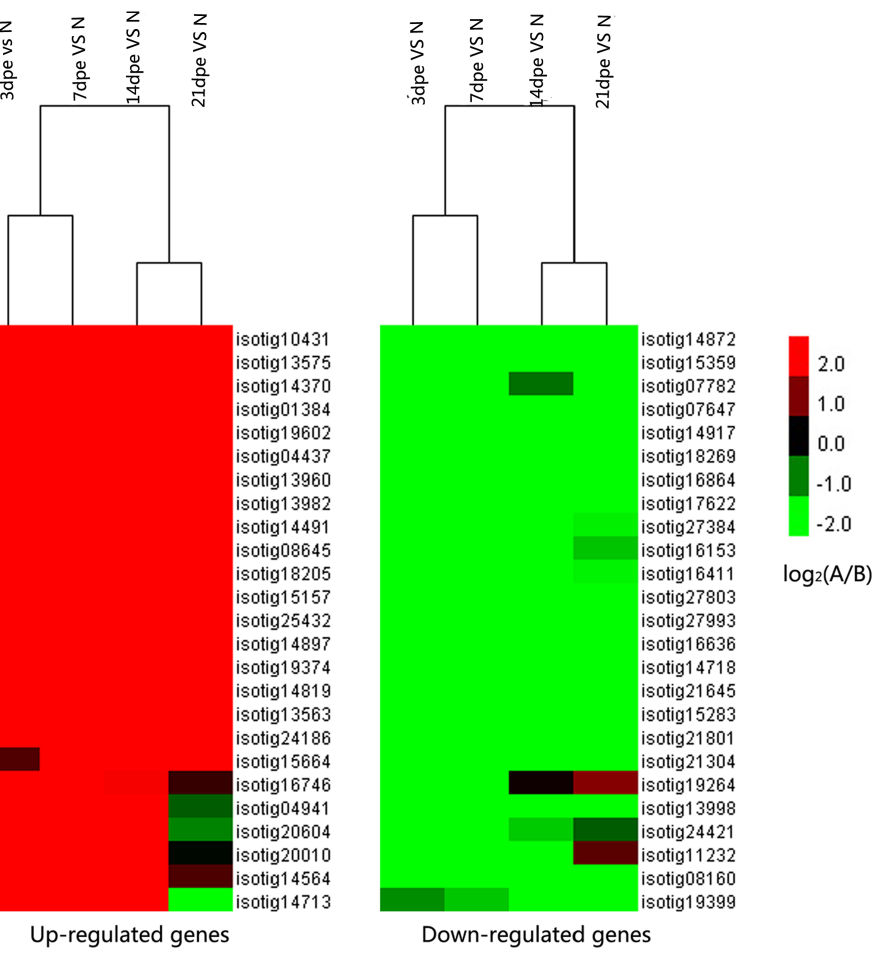
Figure 2. The expression pattern of top significantly differentially expressed genes at 3dpe, 7dpe, 14dpe and 21dpe. Expression differences were shown in different colors. Red mean up regulation and green mean down regulation.